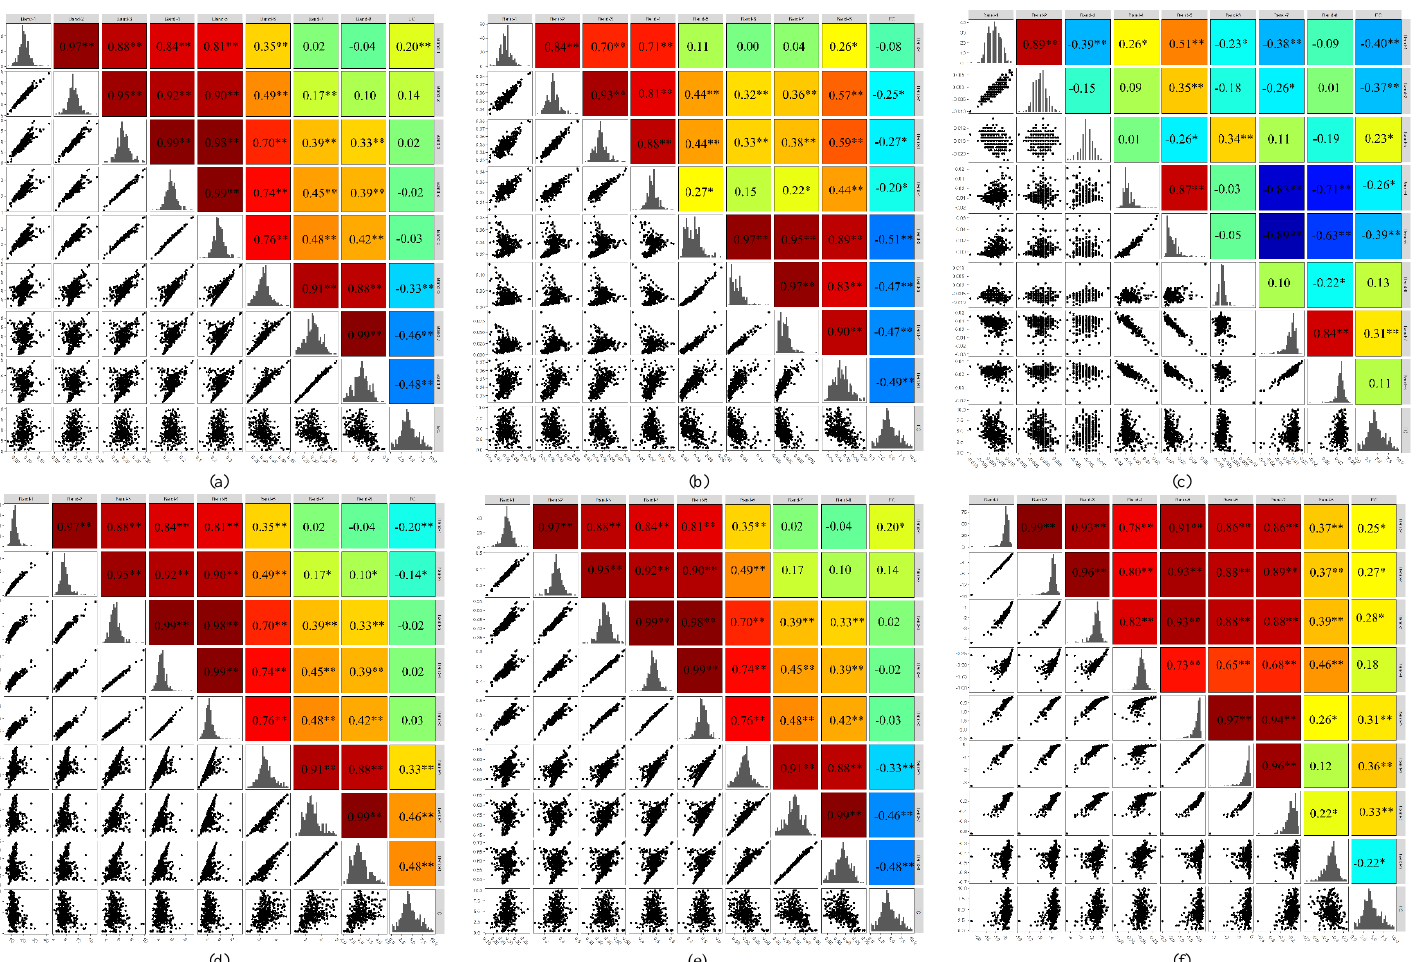
Figure 4. Correlation between EC and bands selected from Worldview-2 image: ( a – c ) the correlation results based on original data, first derivative (R-FD) data, and second derivative (R-SD) data, respectively, and ( d – f ) the correlation results based on reciprocal inverse (1 / R) data, square data (R-SQ) data, and reciprocal first derivative (1 / R-FD) data, respectively. Note: * a means pass the significant test (0.05), ** a means pass the significant test